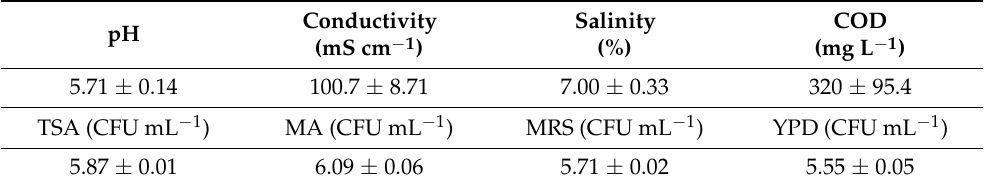
Table 1. Characteristics of WB from the salting process of Kimchi cabbage.